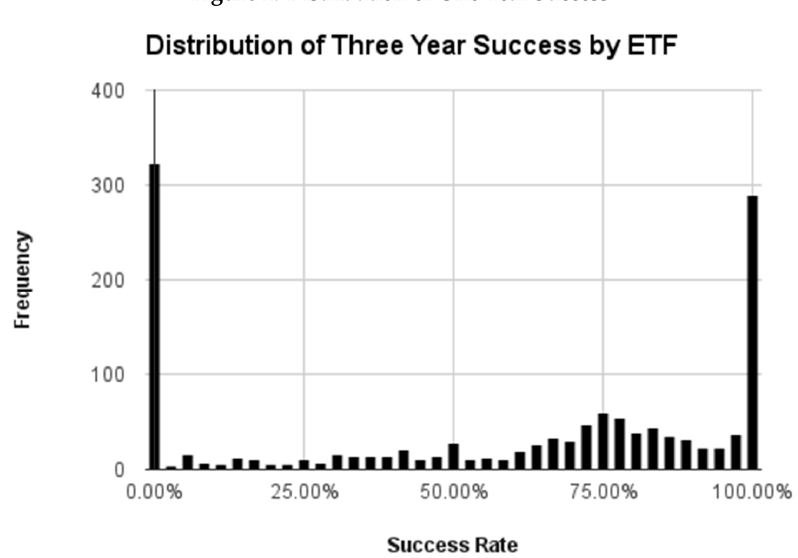
Figure 3. Distribution of Three Year Success.